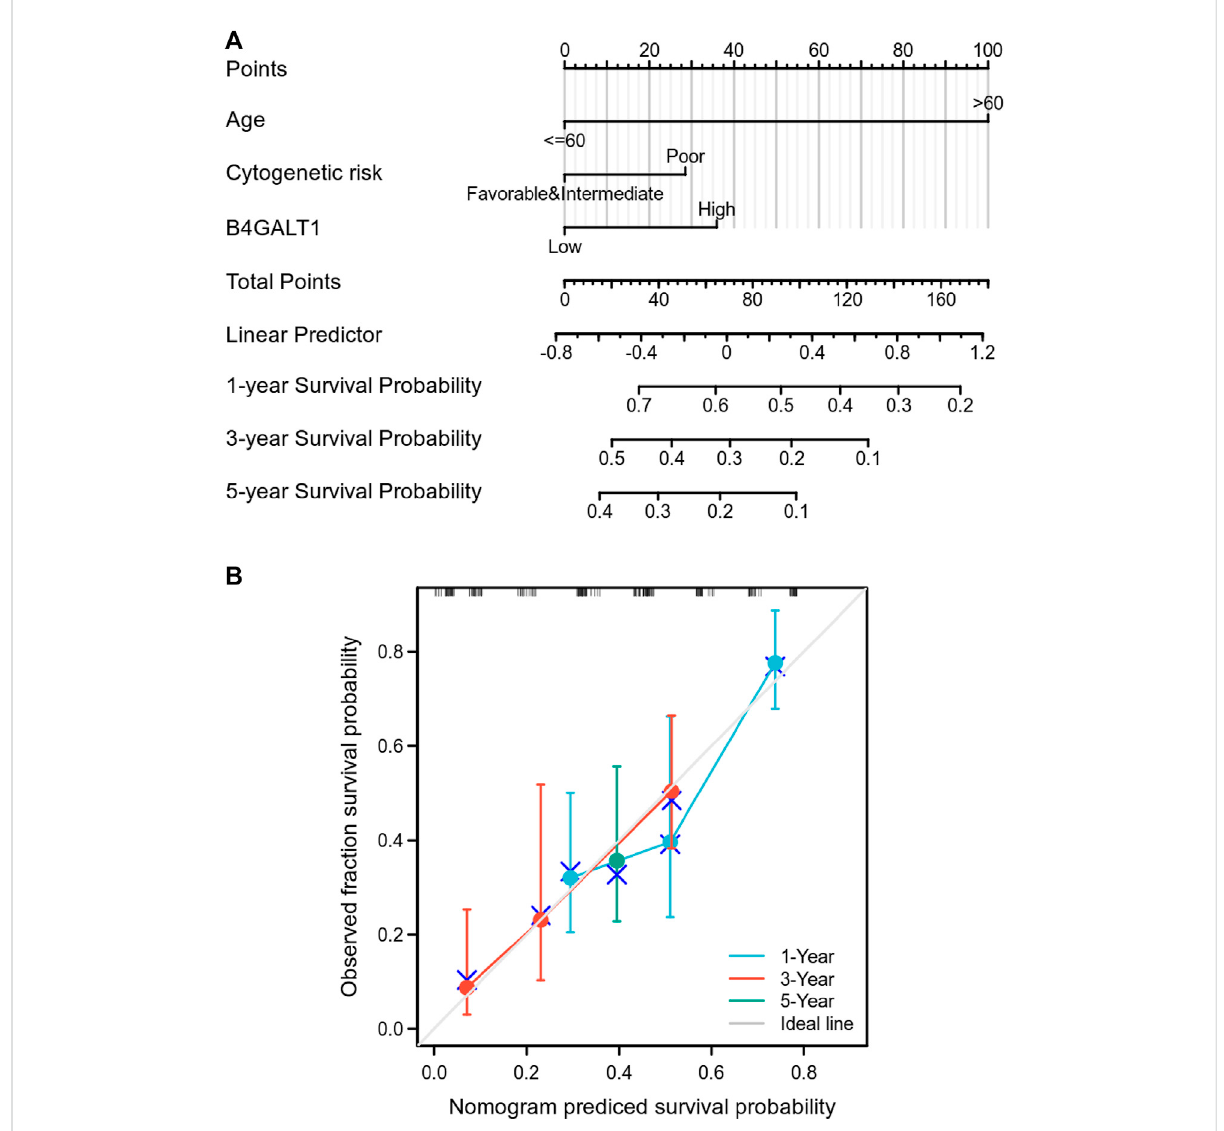
FIGURE 4 Relationship between B4GALT1 and other clinical factors with overall survival (OS). (A) Nomogram for predicting the probability of 1, 3, and 5- year OS for LAML patients. (B) Calibration plot of the nomogram for predicting the OS